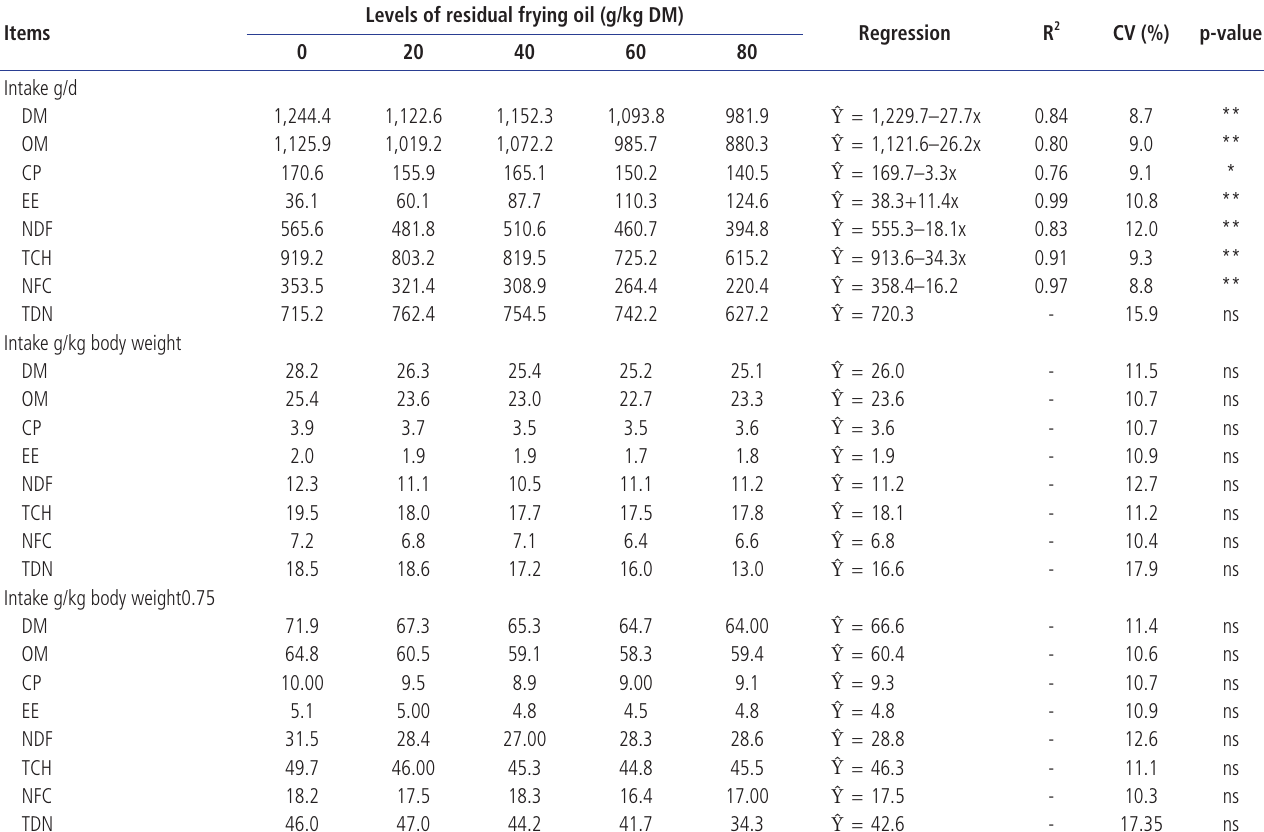
Table 2. Means, regression equations, regression coefficients, and variance coefficients for nutrient intake of diets for lambs with different levels of residual frying oil Levels of residual frying oil (g/kg DM) Items